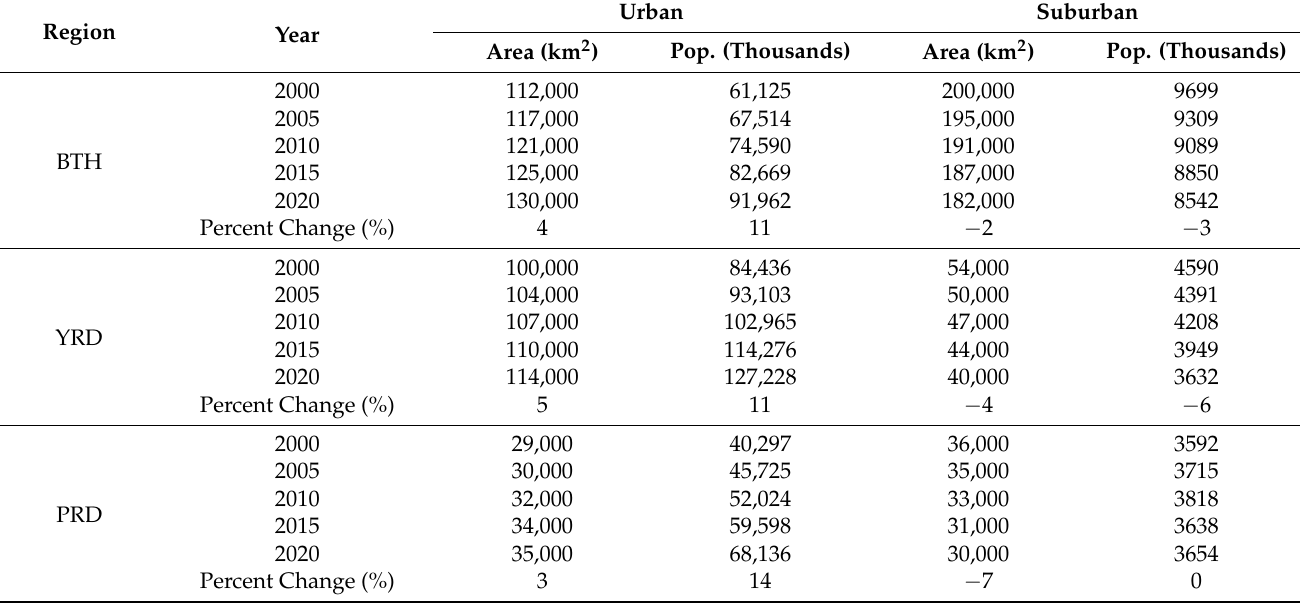
Table 1. The variations in urban and suburban areas and populations from 2000 to 2020. Urban Suburban Region Year Area (km 2 ) Pop.